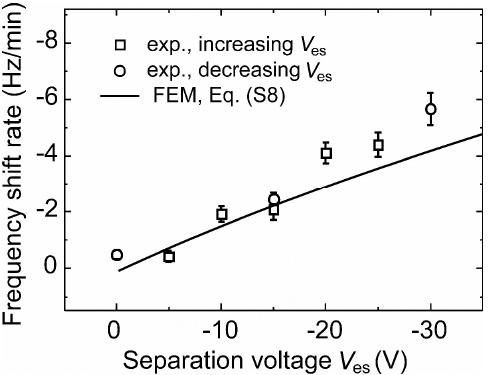
Figure 6. Frequency-shift rate and calculated curve using Equation (A8) from finite element modelling (FEM) measured at different sampling voltages.